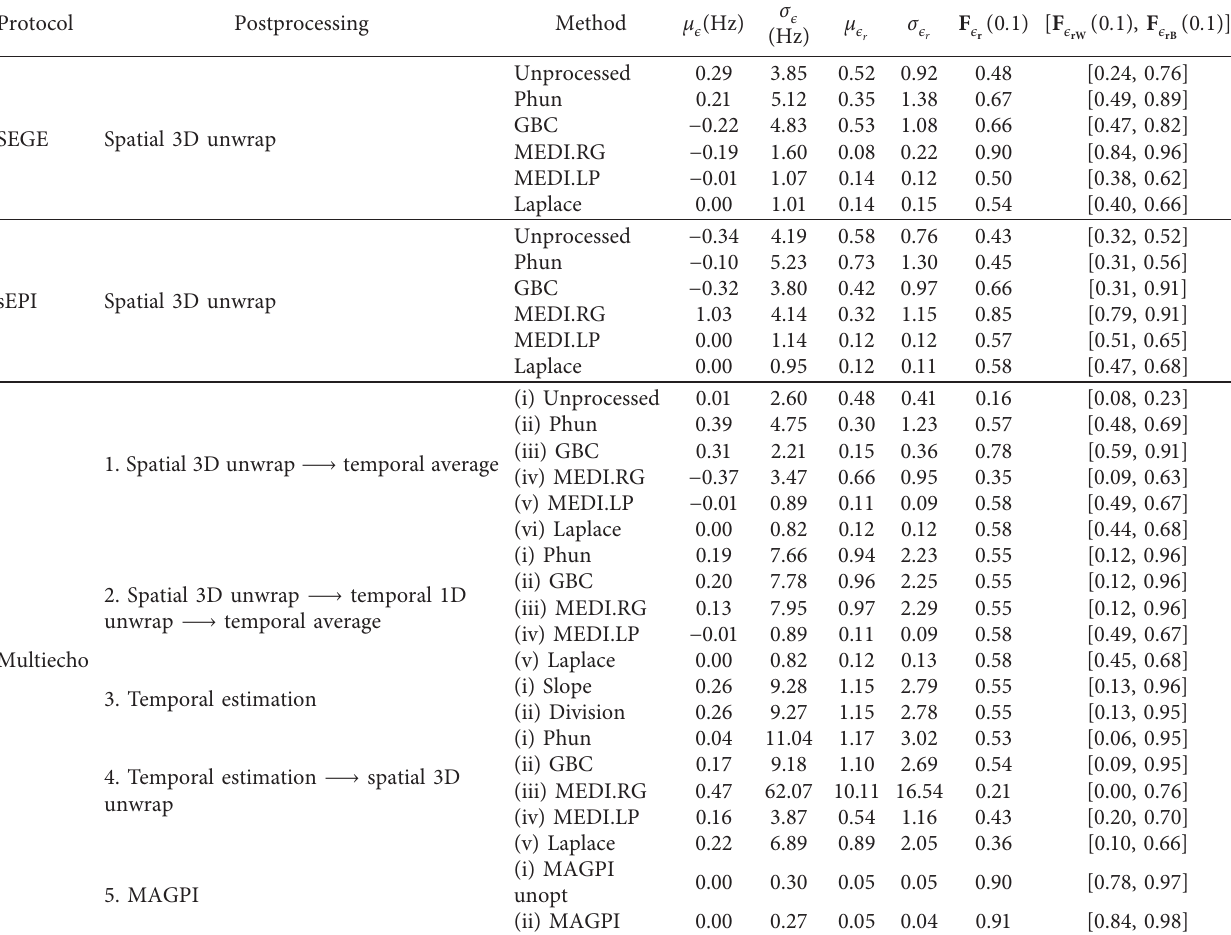
Figure 3: (a) The histogram of the error ε (in Hz) when the measurement is obtained with the SEGE+GBC phase estimation method. The seen with the error data is pooled over all ROI voxels, all backgrounds, rotations, and tubes. (b) The histogram of the absolute relative error ε r same measurement. (c) The corresponding Cumulative Distribution Function F of the error in (b). The inset figure shows a portion of this ϵ r CDF within [0, 0.3] to better illustrate the distributions within reasonable error range. In this case, the CDF shows that the probability of obtaining ε less than 0.1 is around 0.66 with the SEGE+GBC pair. The maximum observed ϵ was 27.0Hz, and the maximum observed ε r r was 6.85, illustrating the occasional large errors that may result with Table 3: Error statistics for each of the estimation methods and acquisition protocols. The mean and standard deviation of error ( 0 . 1 ) of the overall data, measurements ε (Hz), as well as the absolute relative errors ε r , are provided in columns 4–7. Columns 8-9 show F ϵ r ( 0 . 1 ) across reference backgrounds. as well as the range (min and max) of F ϵ r